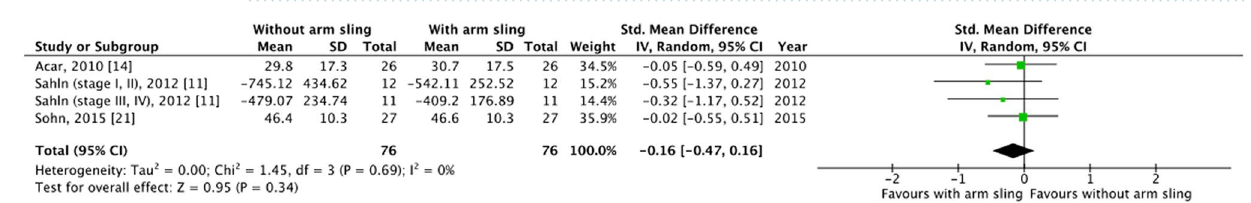
Figure 4. Forest plot for functional balance tests comparison.